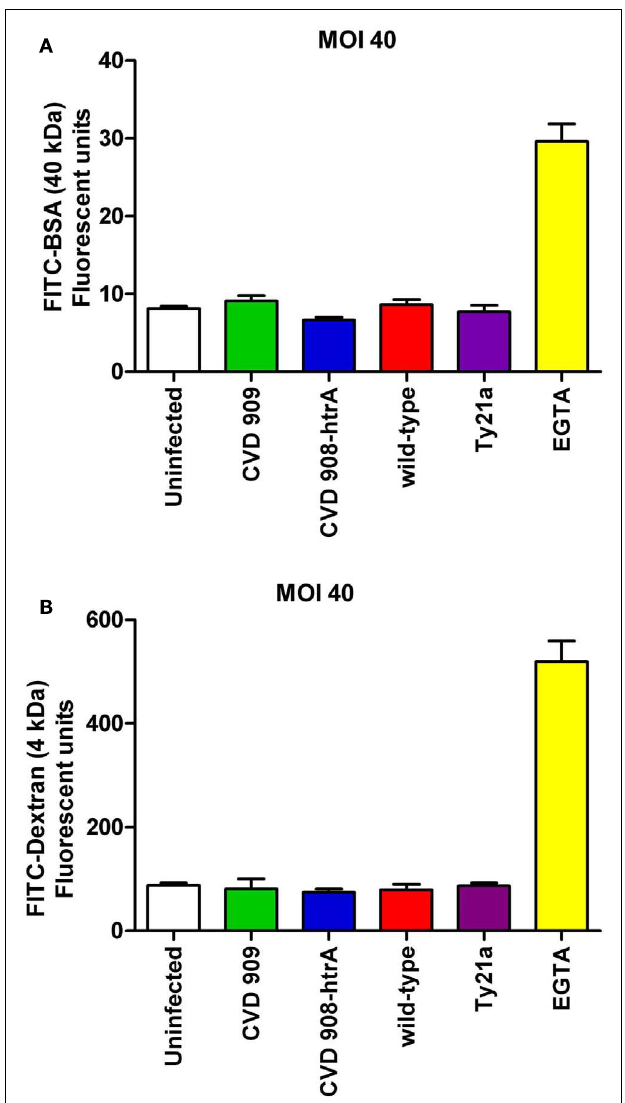
FIGURE 5 | Paracellular permeability in Caco2 cell monolayers after infection with wild-type S .Typhi and its mutant strains (MOI 40:1). (A) FITC-BSA (40kDa) net transport after infection with wild-type S .Typhi and attenuated strains. (B) FITC-Dextran (4kDa) net transport after infection with wild-type S .Typhi or the attenuated mutants. Calcium-free medium supplemented with EGTA to disruptTJs served as positive control. Results are expressed as mean ± SEM of triplicate samples for each condition and are representative of three experiments with similar results. p = ns compared to uninfected controls